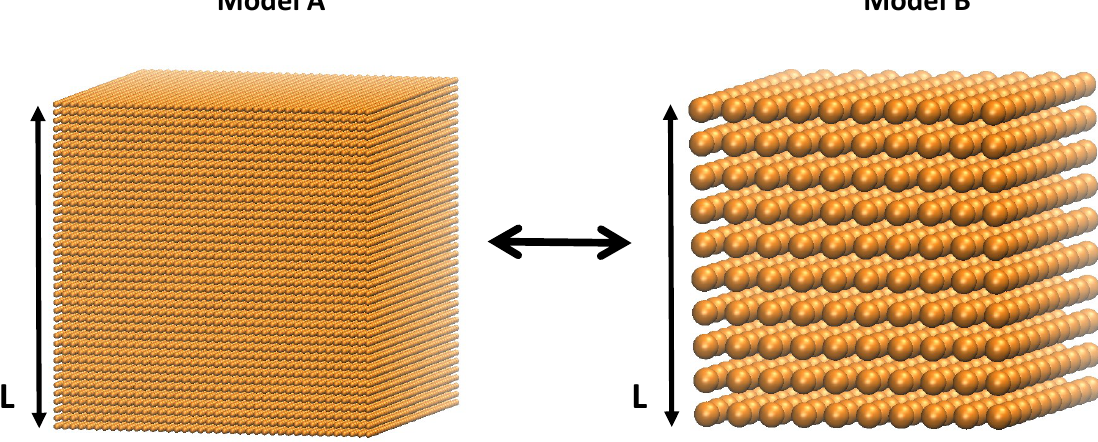
Figure 2. Particles are initiated into a regular cubic lattice. The model’s properties are independent of number of